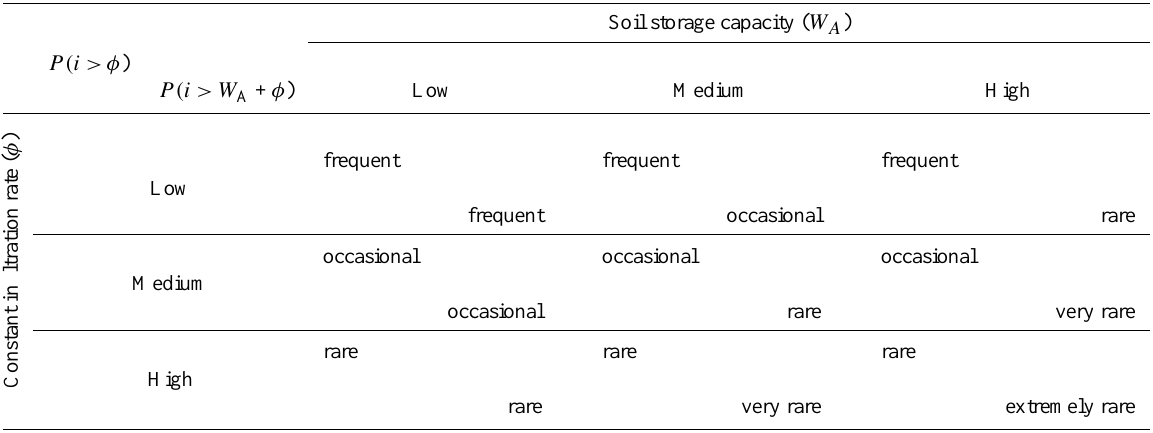
Table 1. Frequency of rainfall exceedance over different thresholds φ and W A .